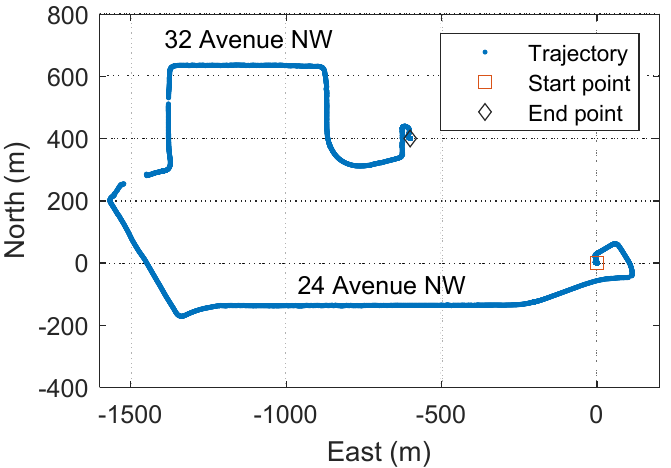
Figure 10. Trajectory of the positioning solutions, where the scale of the east axis and the scale of the north axis are identical.